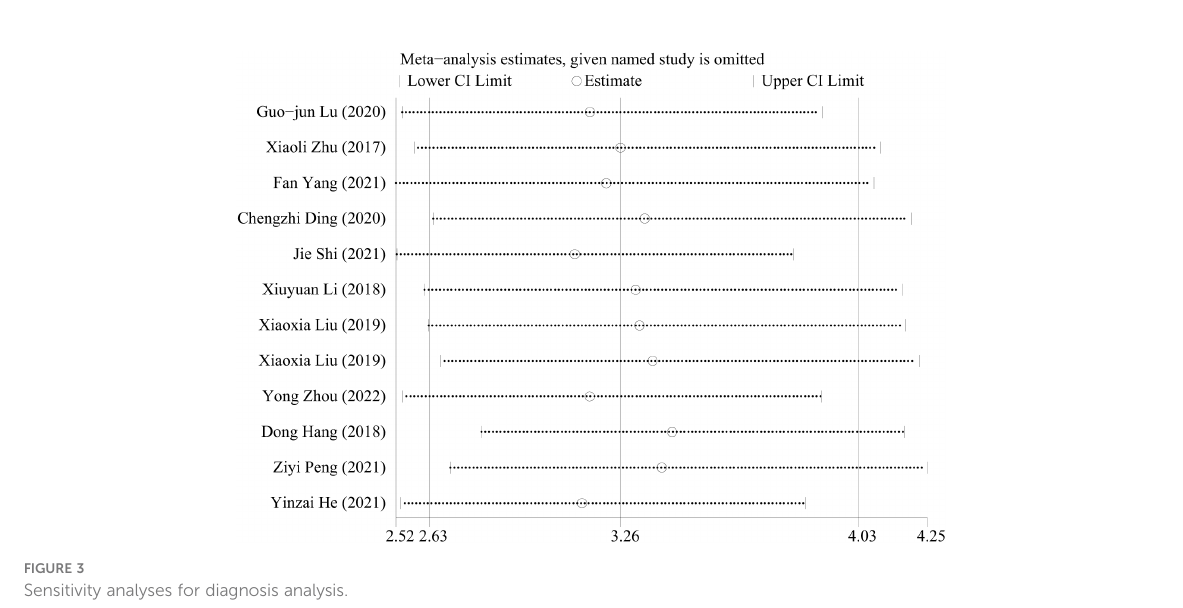
FIGURE 3 Sensitivity analyses for diagnosis analysis.